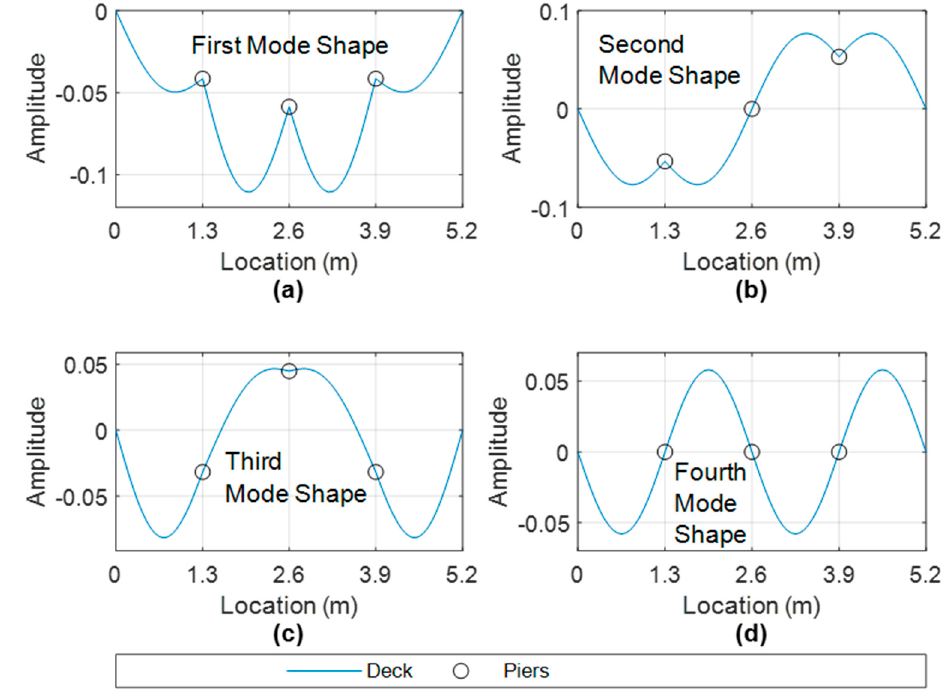
Figure 5. First four mode shapes of the numerical system (for healthy case)—( a ) 9.66 Hz , ( b ) 10.55 Hz , ( c ) 12.08 Hz , ( d ) 13.85 Hz .